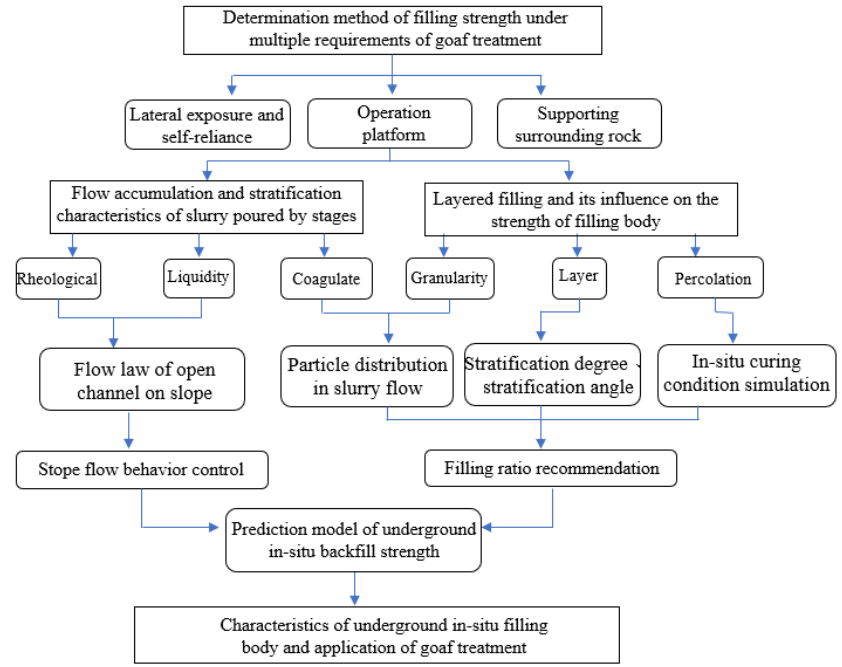
Figure 1. Work flow chart.